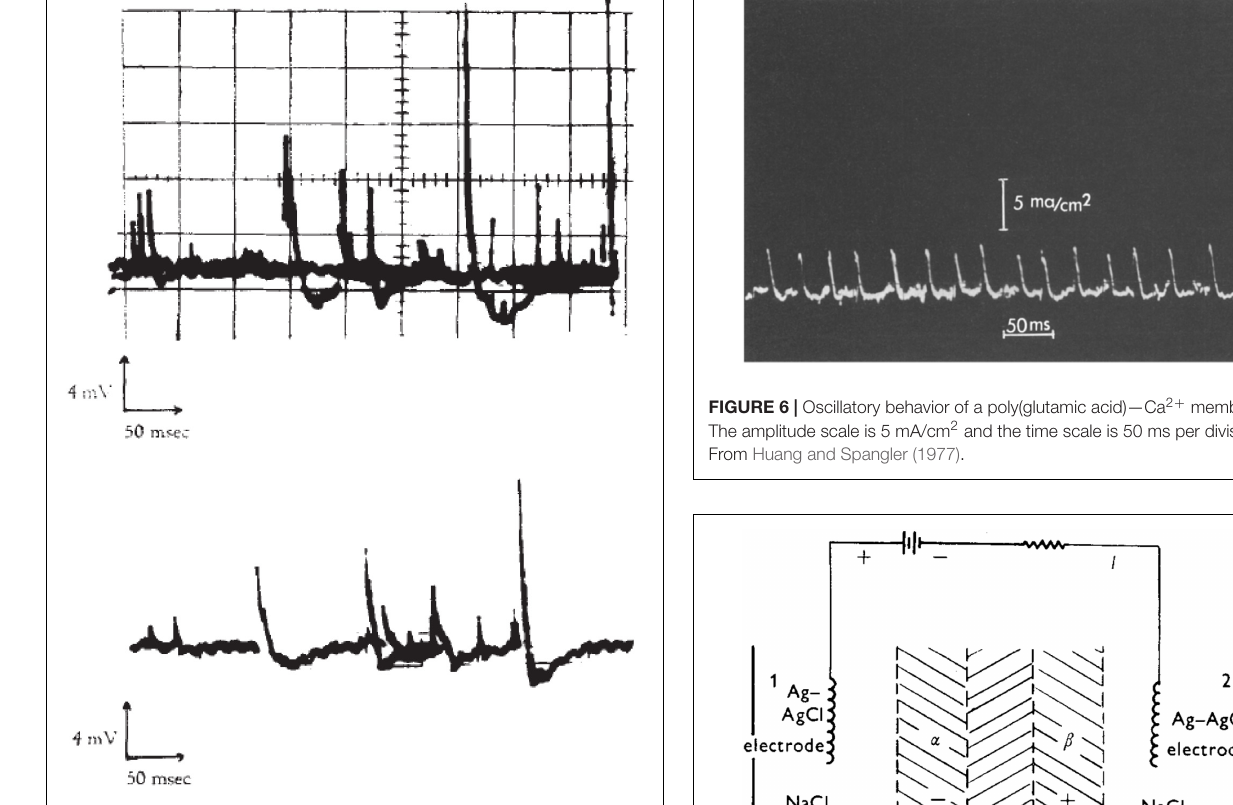
FIGURE 5 | Oscilloscope traces of spikes generated by polyelectrolyte membranes. From Shashoua (1967).